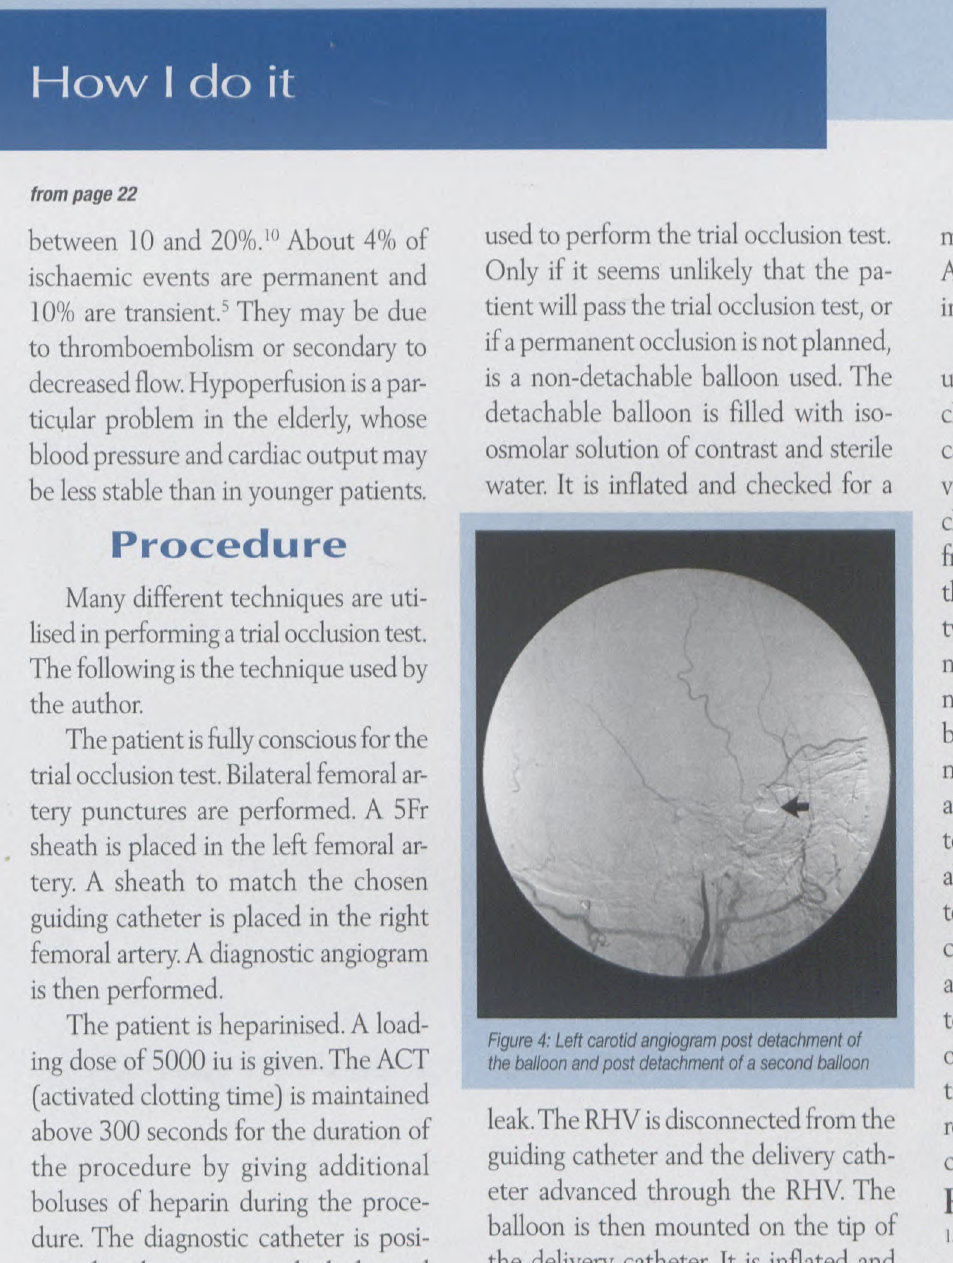
Figure 4: Left carotid angiogram post detachment of the bal/aan and post detachment of a second